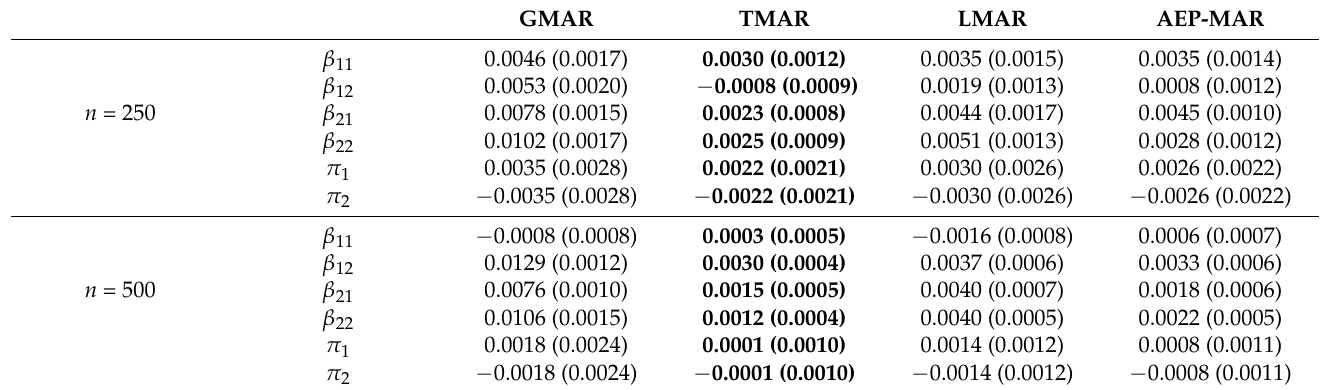
Table 5. Simulation results for Scenario 3 .